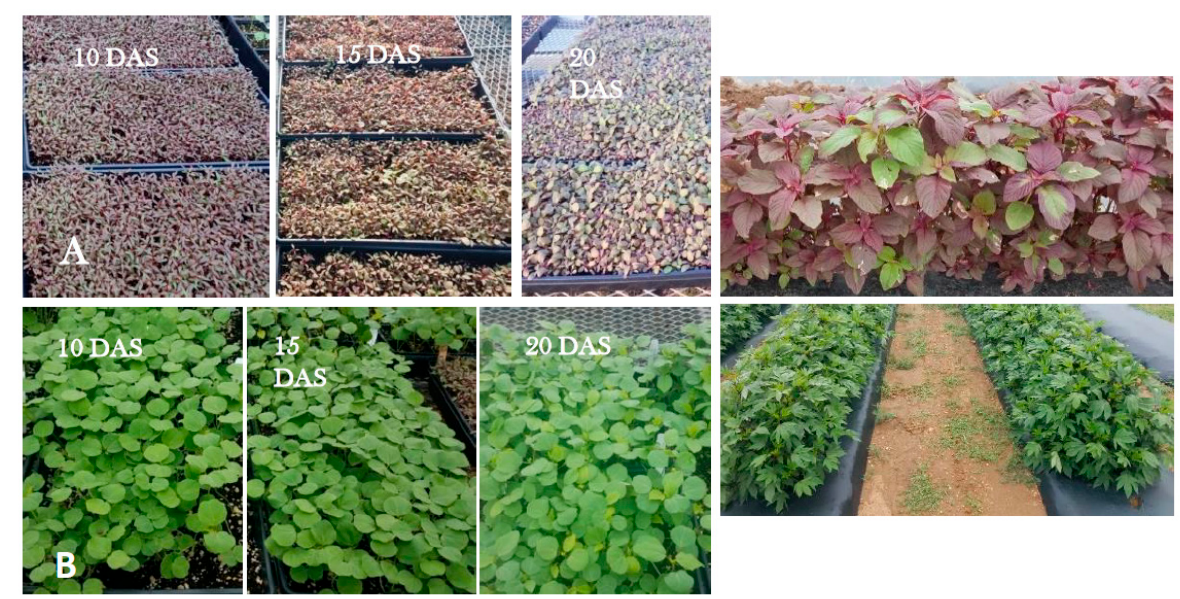
Figure 1. Micro/baby-greens of ( A ) tropical spinach, and ( B ) roselle at 10, 15, and 20 days after sowing (DAS); photos to the right show field grown tropical spinach (Caribbean red) (Top) and roselle (Indian Red-Red) (bottom) at the time of sampling for nutritional status determination. Photos by Albert Ayeni.